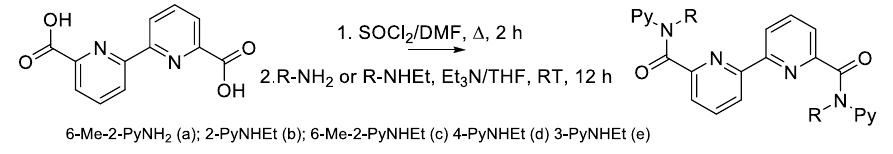
Table 1. Chemical shifts (in ppm) of aromatic protons for 2c ligand and their complexes. Compound Number and